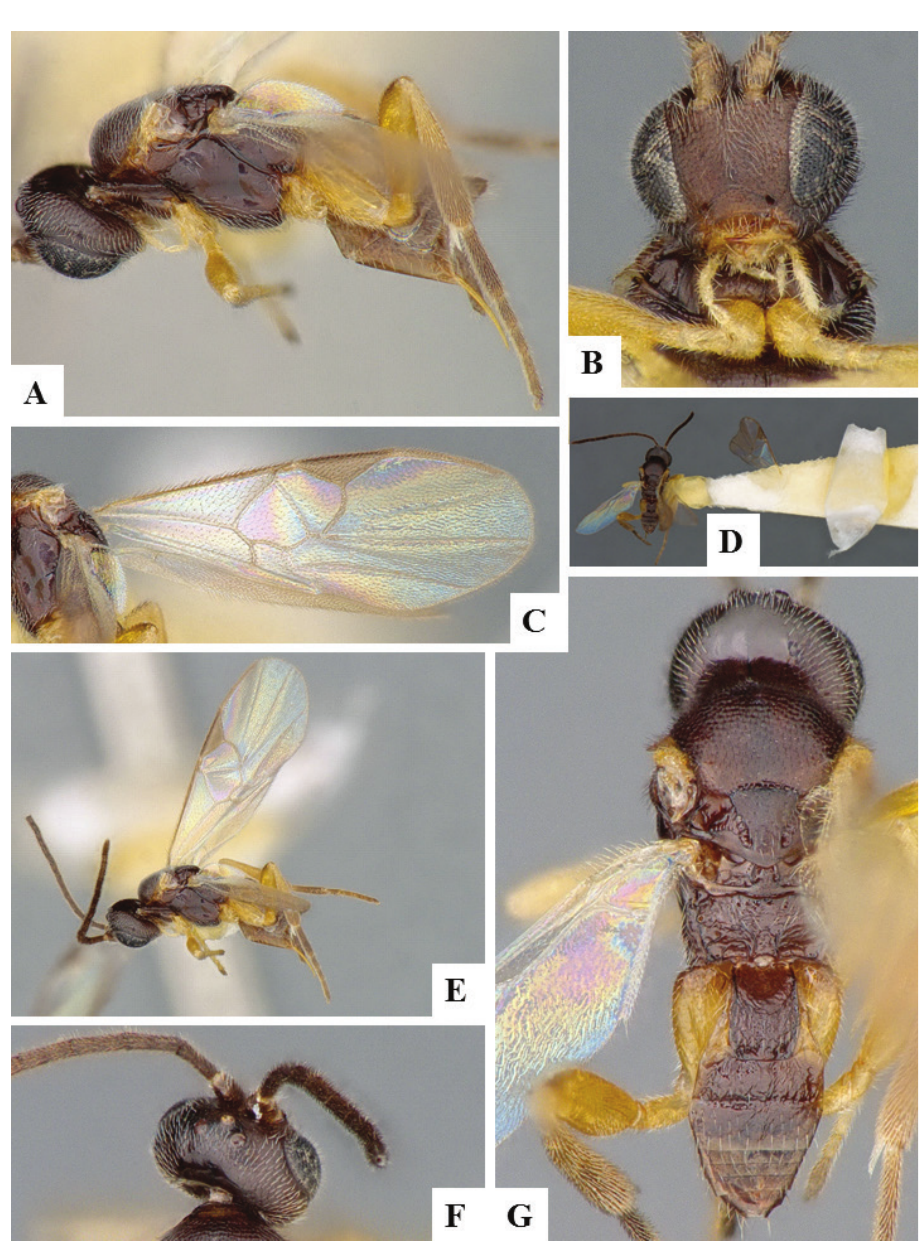
Figure 32. Pholetesor ornigis. A Head and mesosoma, lateral B Head, frontal C Wings D Glued specimen and cocoon E Habitus, lateral F Head, dorsal G Habitus,